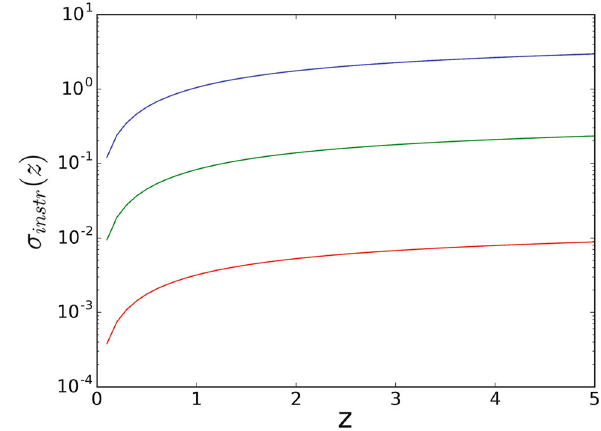
Fig. 3 The device error σ instr ( z ) for DECIGO (Red line), ET (green line) and aLIGO (blue line),